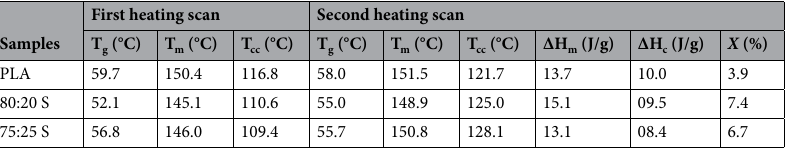
Table 1. DSC data of neat PLA and PLA-HA polymer composite filaments. T g glass transition temperature, T